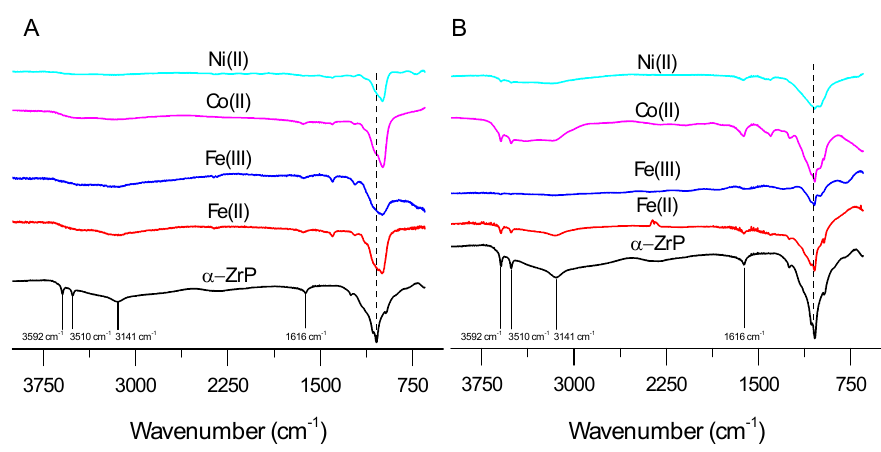
Figure 2. FTIR spectra of ( A ) intercalated and ( B ) adsorbed Fe(II), Fe(III), Co(II), and Ni(II) at 10:1 M:ZrP ratio.